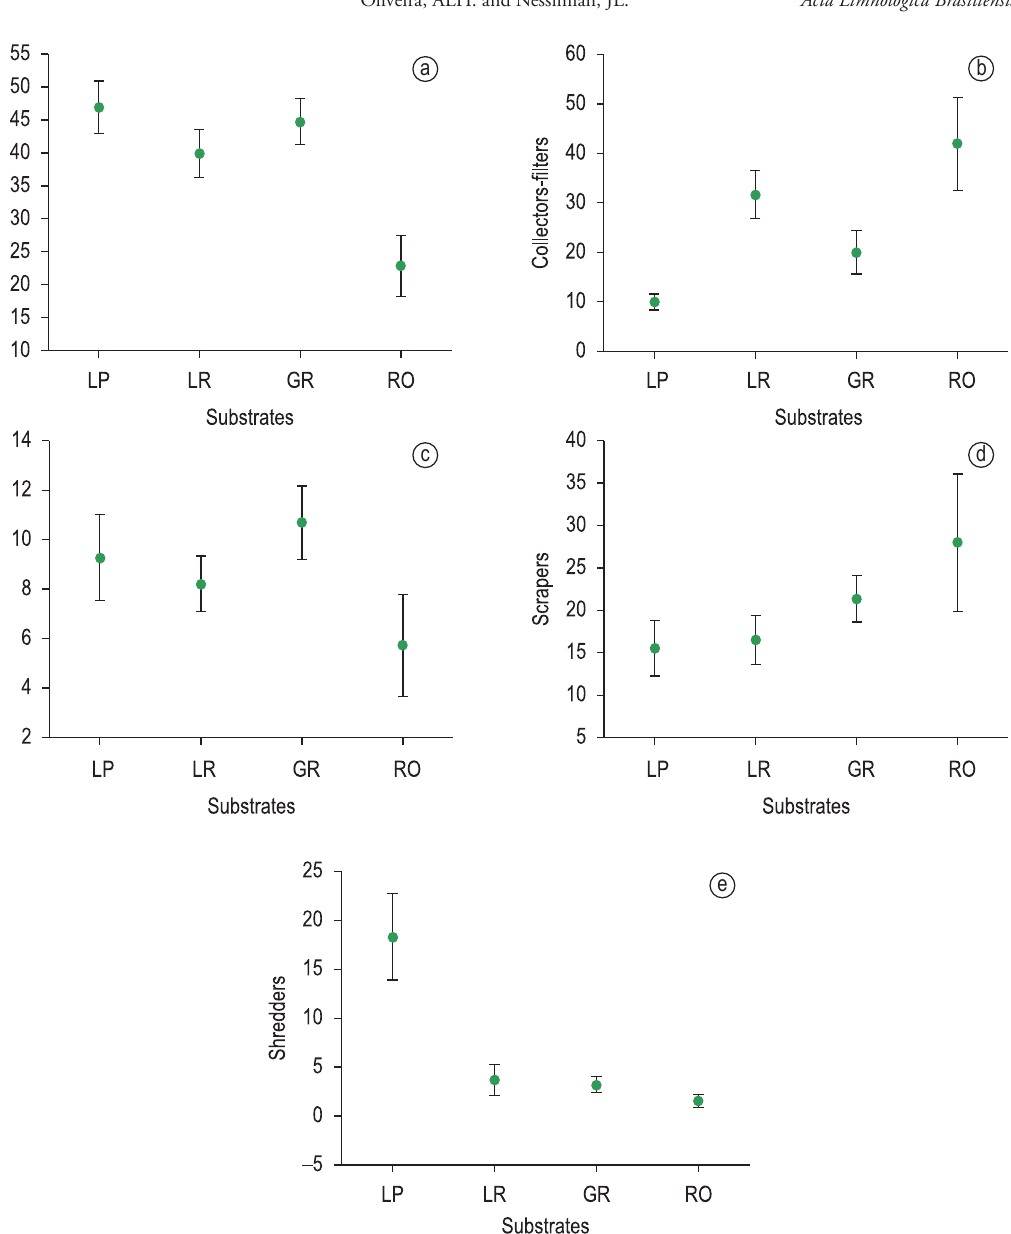
Figure 4. Mean (Max-Min) Tukey HSD test results found to each functional feeding groups and substrates (p < 0.05). LP = pool litter, LR = riffle litter, GR = gravel and RO =